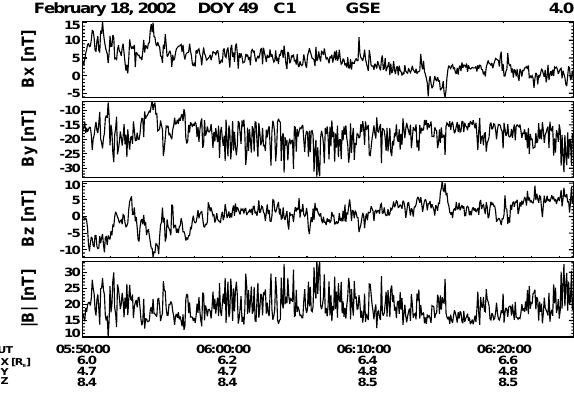
Fig. 3. Measurements of the magnetic field vector components and the magnitude B made by spacecraft C1 on 18 February 2002, 05:50–06:24.